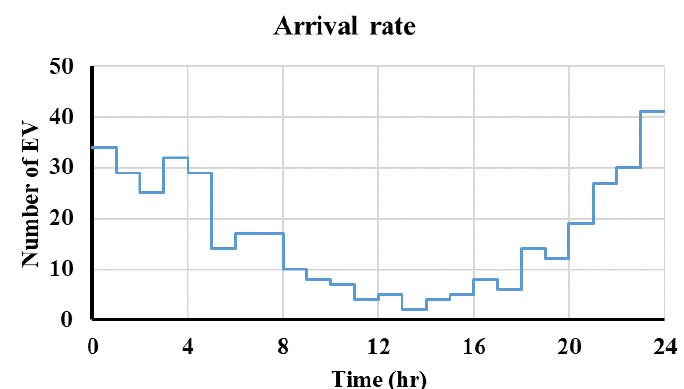
Figure 8. The arrival rate of the EV.